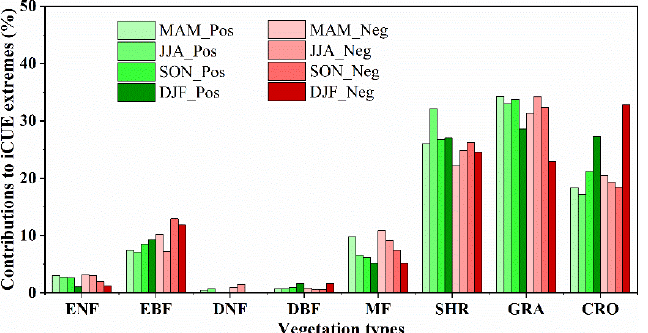
Figure 3. The contribution of vegetation types to CUE extremes. “MAM” contains the month of March, April, May; “JJA” contains the month of June, July, and August; “SON” contains the month of September, October, and November; “DJF” contains the month of December, January, February. “Pos” represent the positive extremes, and “Neg” represent negative CUE extremes. “ENF” is evergreen needleleaf forest, “EBF” is evergreen broadleaf forest, “DNF” is deciduous needleleaf forest, “DBF” is deciduous broadleaf forest, “MF” is mixed forest, “SHR” is a shrub, “GRA” is grass, and “CRO” is cropland.